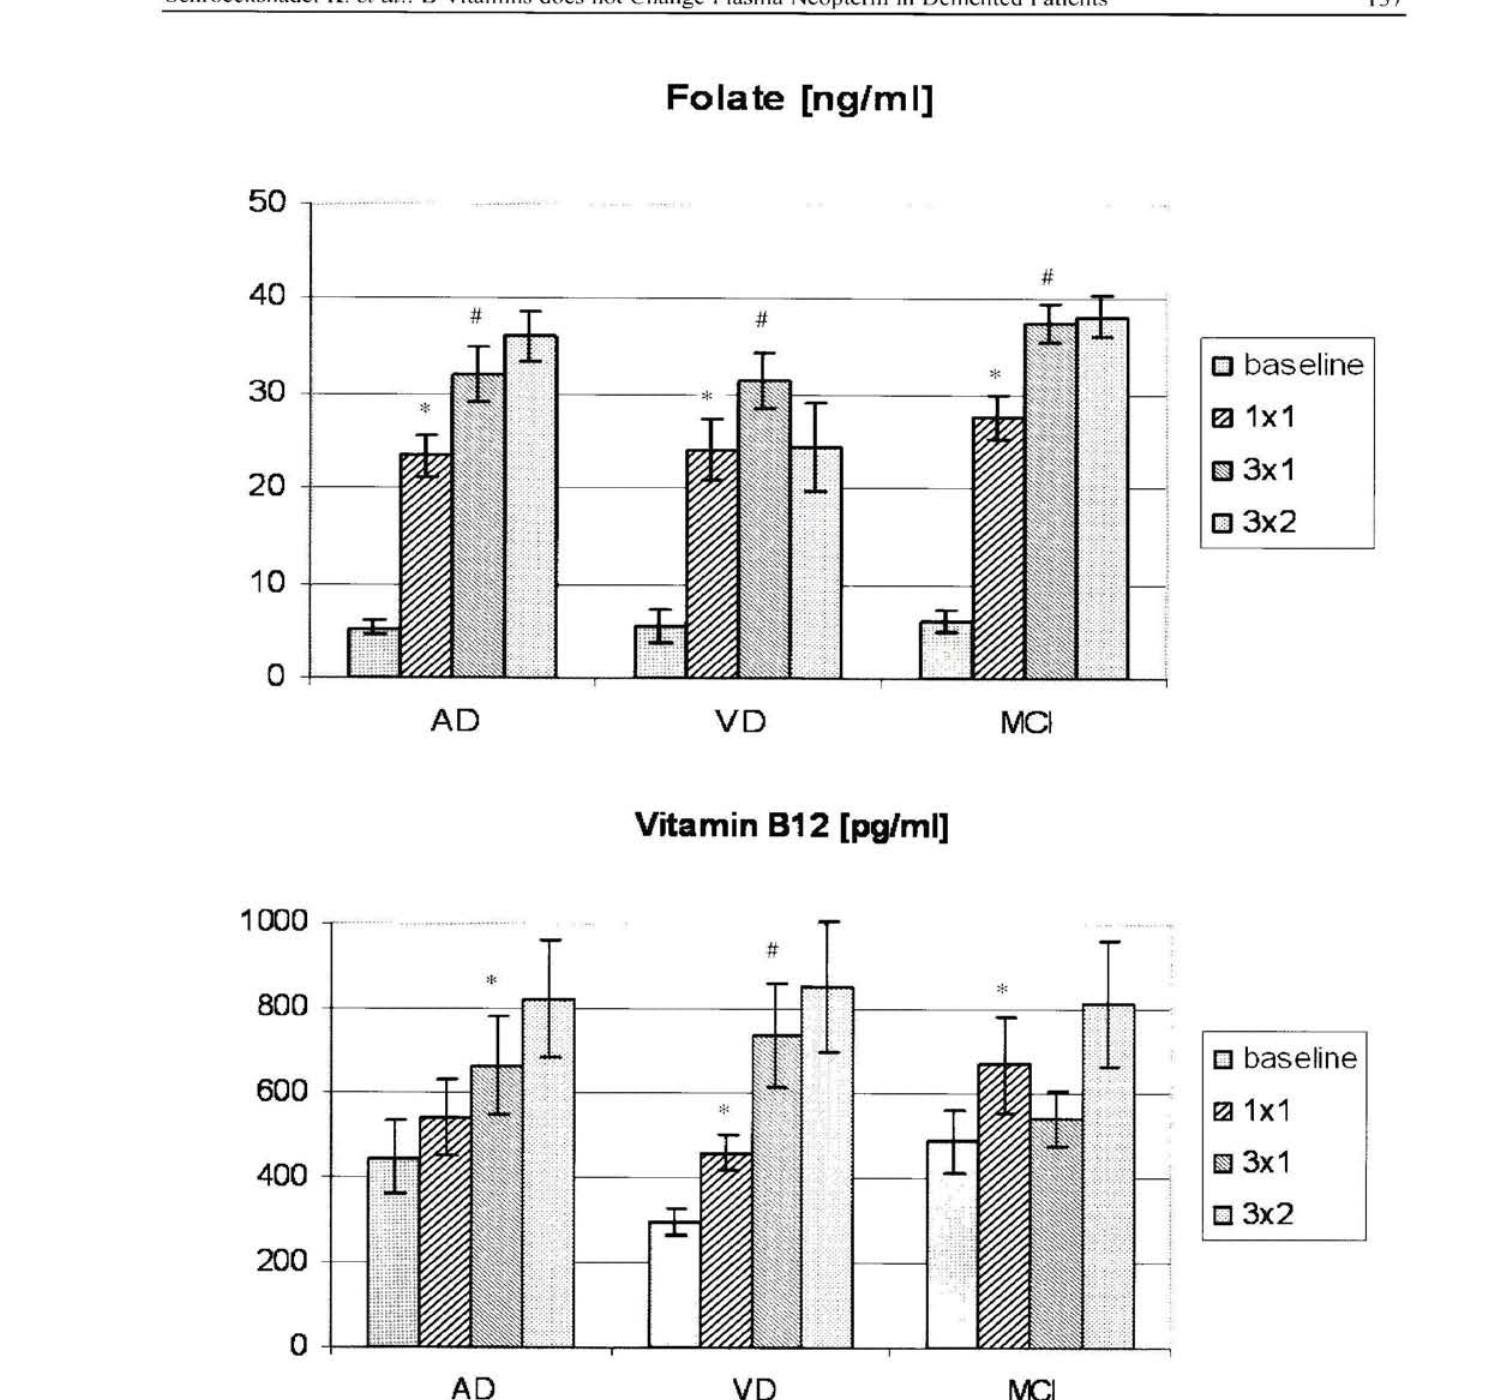
Figure 1. Concentrations (mean ± S.E.M.) of folate (left) and vitamin B12 (right) at baseline (white bars] and after supplementation with Β vitamins (Beneuran compositum TM lxl tablet/day, 3X1 tablets/day, 3X2 tablets/day - hatched bars) in patients with Alzheimer disease (AD), vascular dementia (VD) and mild cognitive impairment (MCI); *p <0.01 compared to baseline, #p <0.01 compared to concentrations at month 1 described earlier (33). Determination of neopterin con- of folic acid and vitamin B12 concentrations double- centrations was performed by ELISA (BRAHMS labelled radioimmunoassay (Chiron Diagnostic Corp., Diagnostica, Berlin, Germany). For the measurement Walpole, MA) was used.